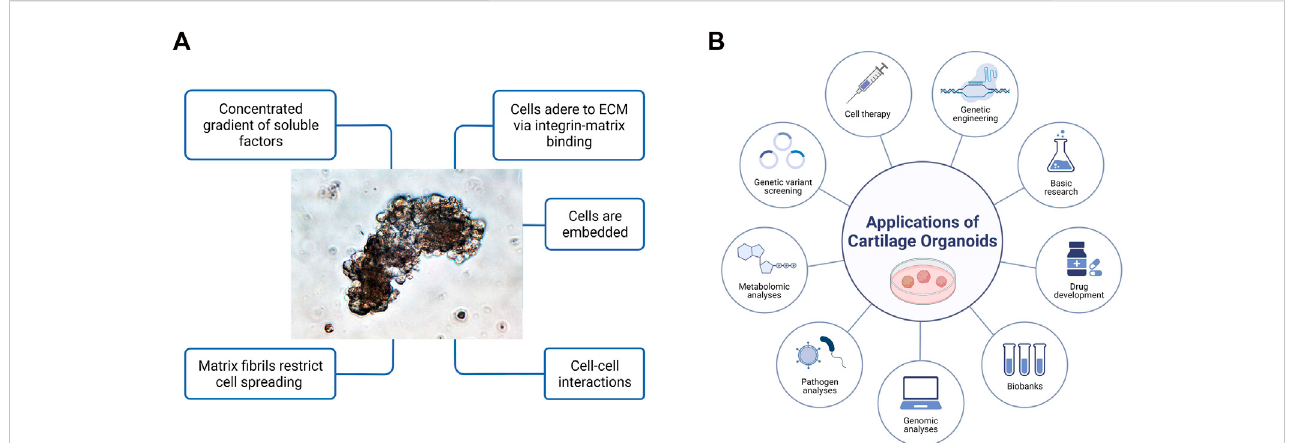
FIGURE 3 (A) General features of three-dimensional cartilage organoids ‘ in a dish ’ . Cells embedded within gels concentrated with various gradients or soluble growth factors are able to adhere to extracellular matrix (ECM),spread andgrow with cell-cellinteractions in3-dimensional space. (B) Diverse applicationsof cartilage organoids for preclinical research and clinical transformation of personalized medicine. Cartilage organoid-based implications mainly include cell therapy through multiple functional cell clusters, drug development, genetic engineering, biobanking, genomic analysis, pathogen analysis, metabolomic analysis, and basic preclinical research.